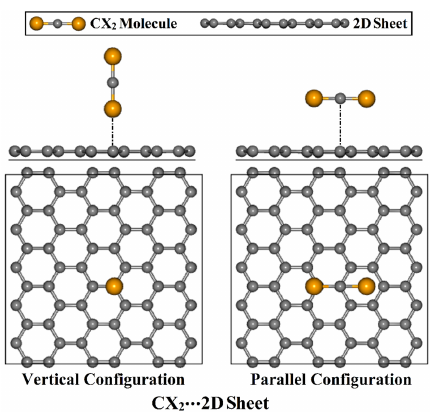
Figure 1. CSe 2 ∙∙∙ GN complex as an illustration for the CX 2 ∙∙∙ 2D sheet complexes (where CX 2 = CO 2 , Figure 1. CSe 2 · · · GN complex as an illustration for the CX 2 · · · 2D sheet complexes (where CX 2 = CO 2 , CS 2 , or CSe 2 and the 2D sheet = β 12 or GN) within vertical and parallel configurations from the side and top representations. CS 2 , or CSe 2 and the 2D sheet = β 12 or GN) within vertical and parallel configurations from the side 2. Computational Methods and top Geometric optimization and energy calculations of the CX 2 ∙∙∙ β 12 /GN complexes (CX 2 ; X = O, S, or Se) were carried out in accordance with density functional theory (DFT) [46,47] via the Quantum ESPRESSO 6.4.1 package [48,49]. To describe the electronic interactions, the Perdew–Burke–Ernzerhof (PBE) exchange-correlation functional of the Generalized